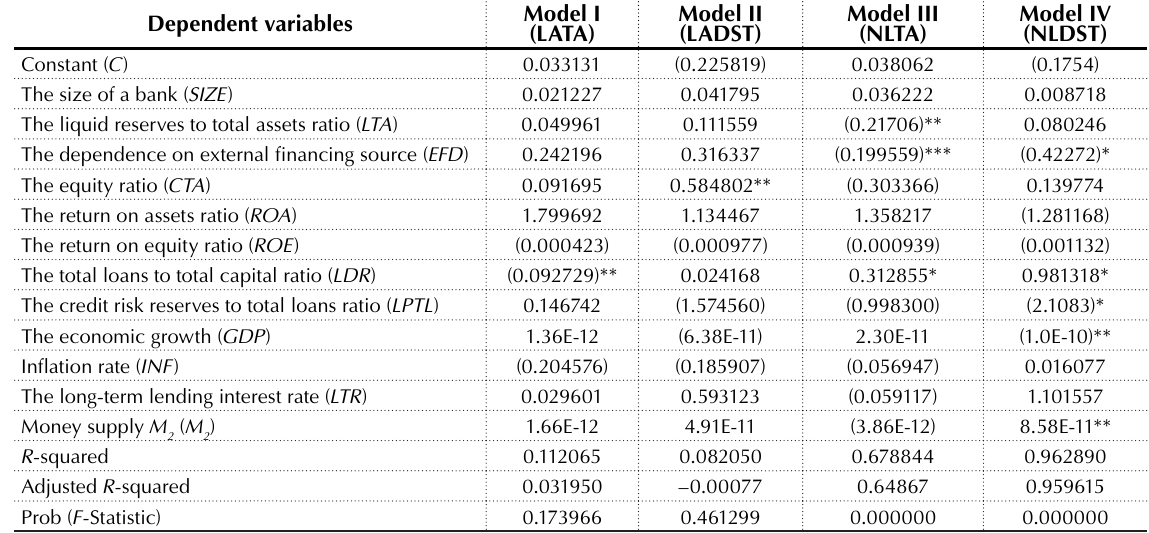
Table A2. The results of four regression models